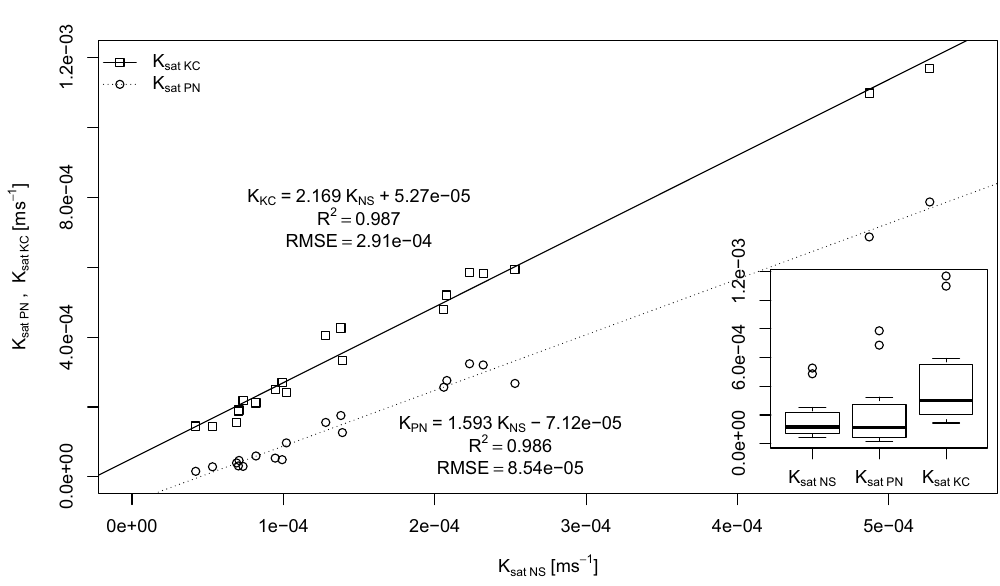
Figure 3. Main plot—saturated conductivities estimated via pore network modeling (K sat PN ) and Kozeny– Carman (K sat KC ) modeling compared with the Navier–Stokes (K sat NS ) estimations. The subplot presents boxplots of the K sat PN , K sat KC, and K sat NS datasets (figure created using RStudio 1.3 software https ://rstud